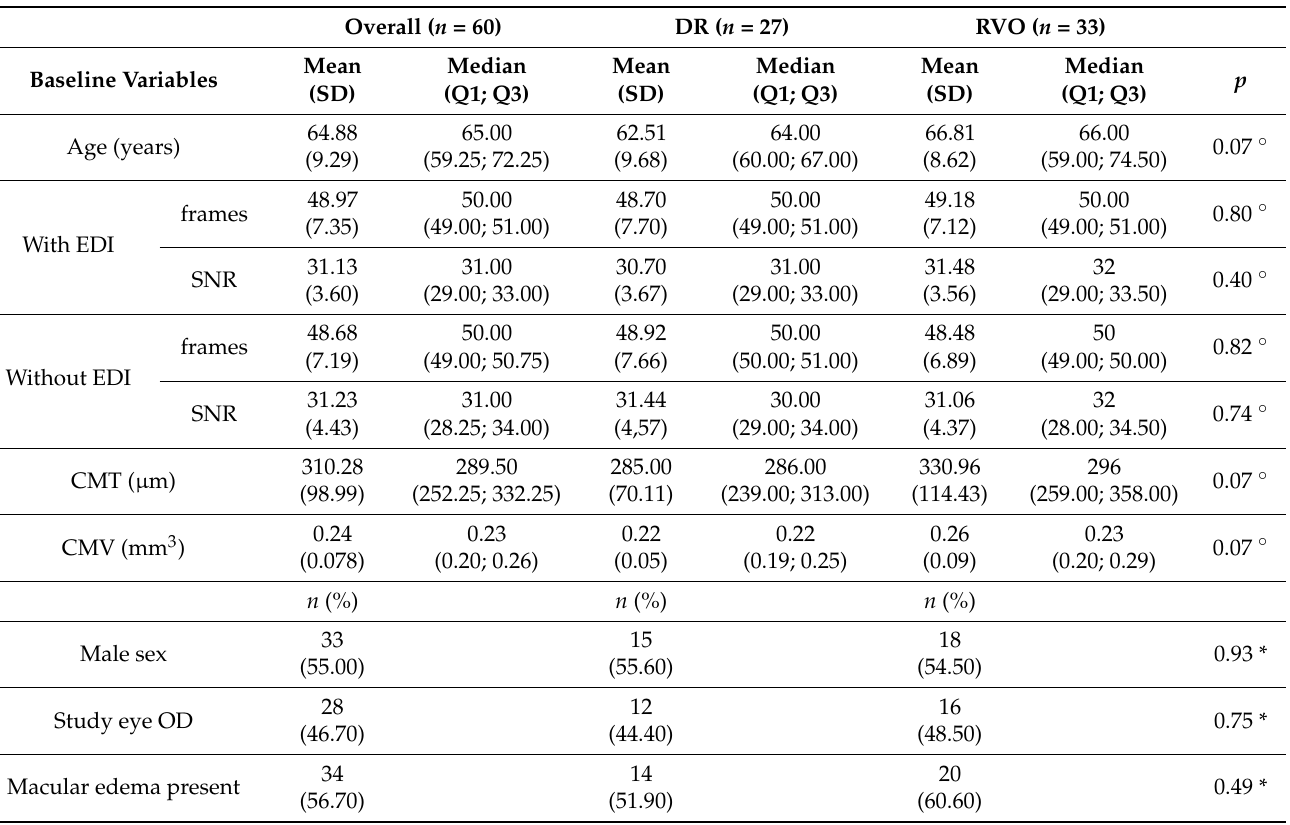
Table 1. Demographics and characteristics for patients with diabetic retinopathy (DR) ( n = 27) or retinal vein occlusion (RVO) ( n =